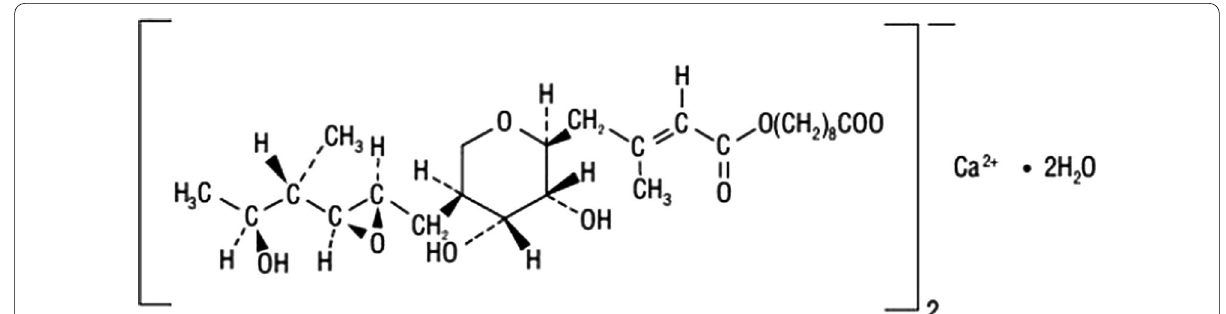
Fig. 1 Chemical structure of Mupirocin